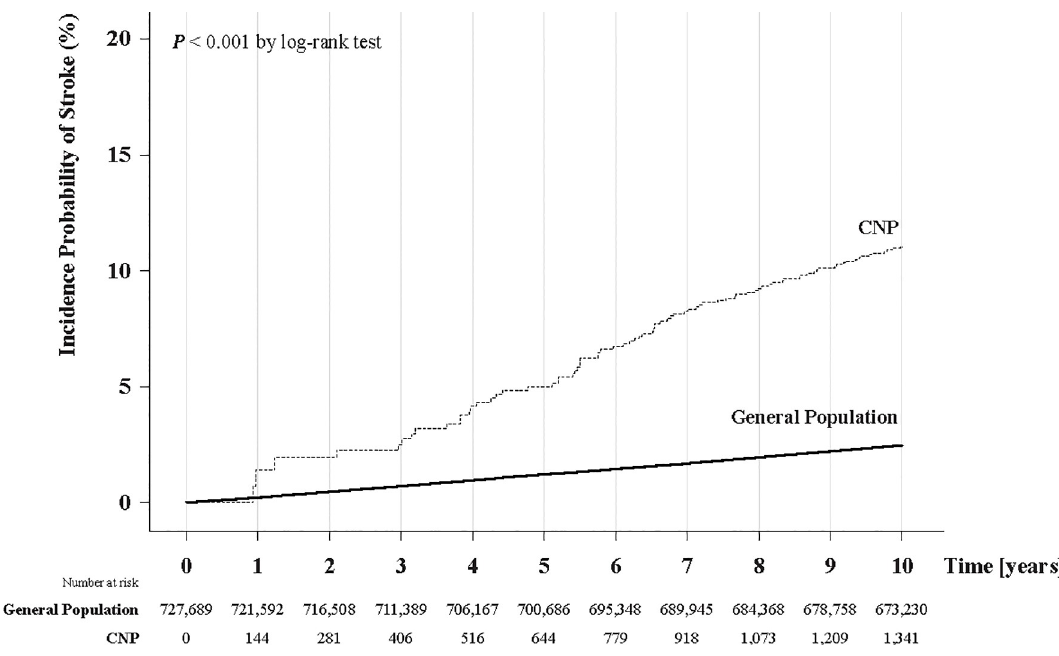
Fig 2. 10-year incident rate of stroke according to occurrence of ocular motor cranial nerve palsy. Kaplan-Meier curves show the time interval from study enrollment to the incidence of stroke. Occurrence of ocular motor cranial nerve palsy increased the probability of incident stroke when estimated with time-varying covariate cox regression analysis ( P < 0.001, log-rank